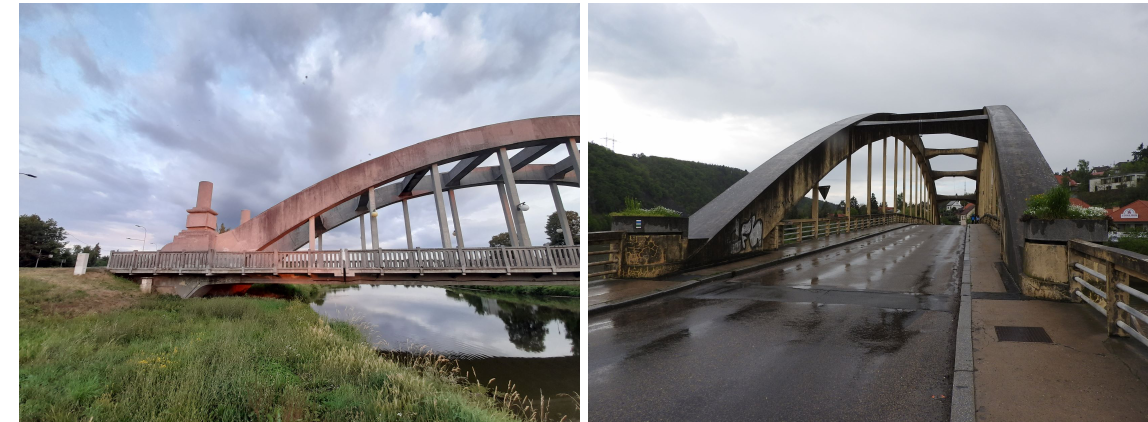
Figure 9. Expansion joints in the deck (left – expansion joint near abutment, Uherský Ostroh, 1927; right – expansion joint between the ends of arches, Štěchovice, 1939).